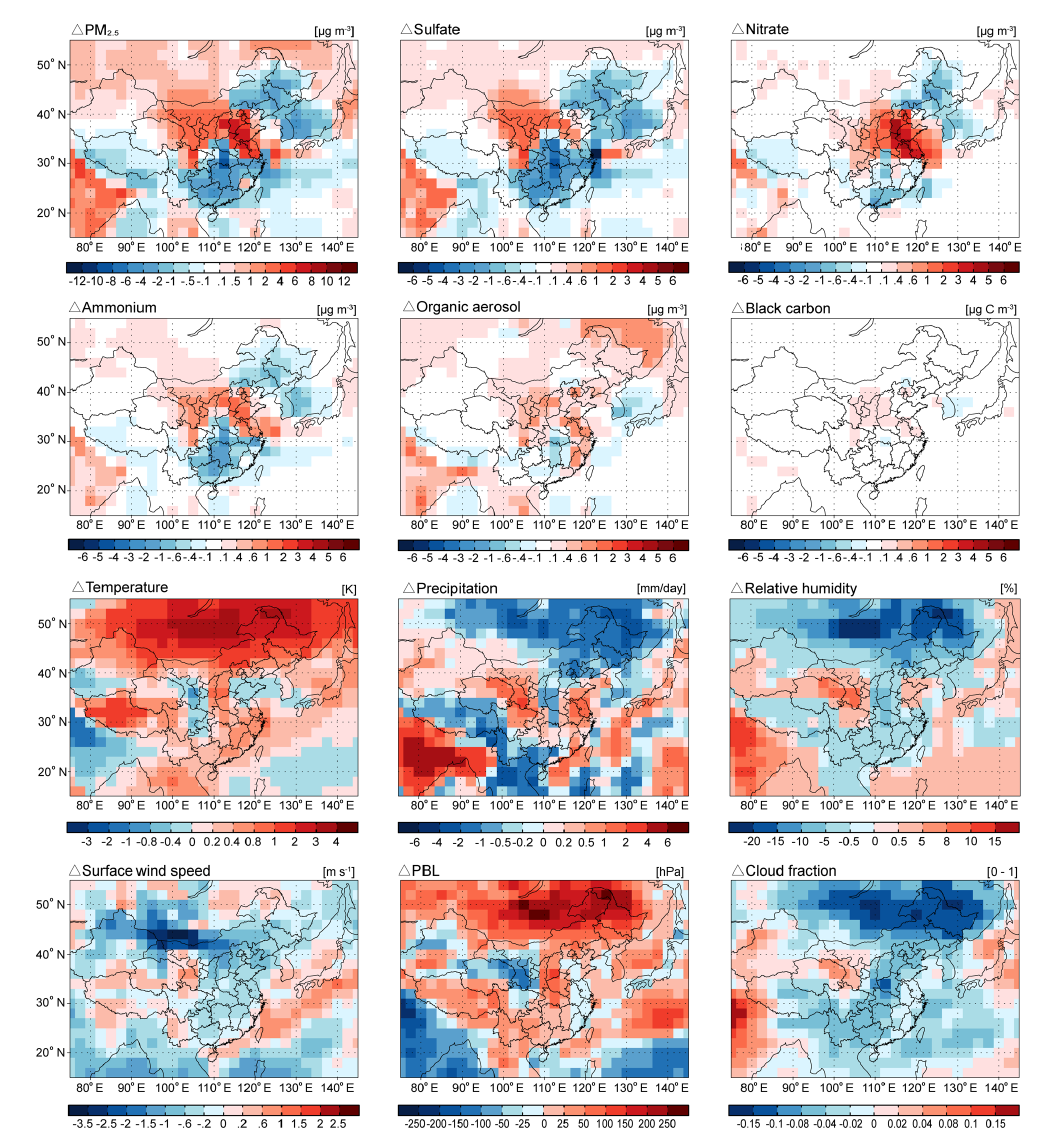
Figure 5. Simulated changes of summertime (JJA) surface concentrations for PM 2 . 5 , sulfate, nitrate, ammonium, organic aerosol, black carbon, surface temperature, total precipitation at the ground, relative humidity, surface wind speed, planetary boundary layer depth